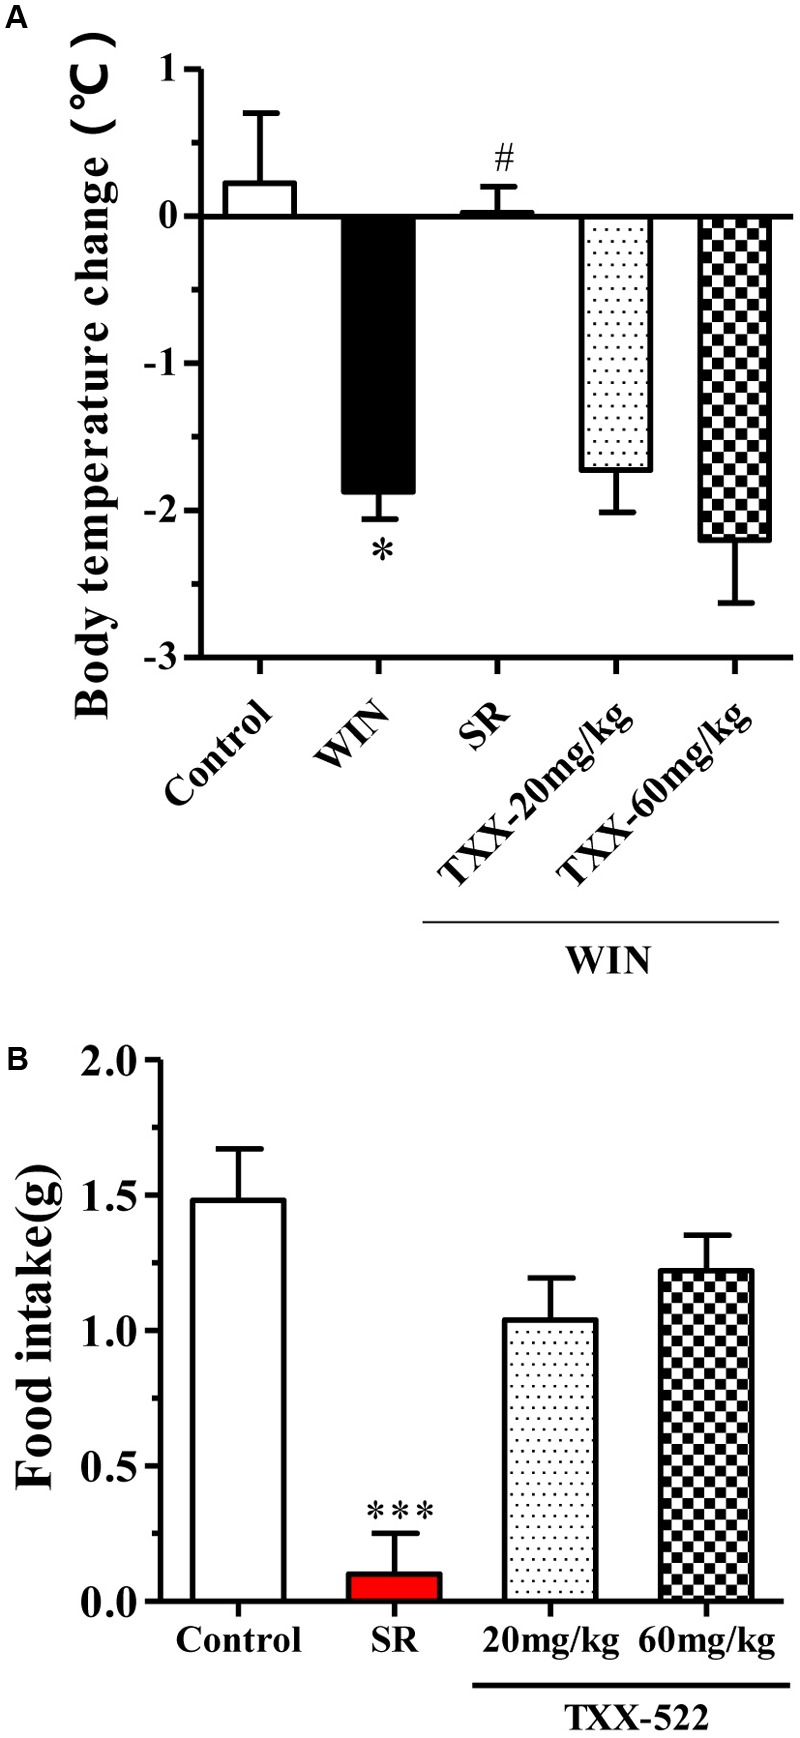
Effects of TXX-522 and SR141716A on WIN 55,212-2-induced hypothermia and acute food intake in C57BL/6 mice. (A) Body temperature change 30 min after intraperitoneal injection of WIN 55,212-2 (WIN, 3 mg/kg), following oral administration of SR141716A (SR, 10 mg/kg) or TXX-522 (TXX, 20 or 60 mg/kg). Data are means ± SEM, n = 5; ∗P < 0.05 vs. vehicle control group, #P < 0.05 vs. the WIN 55,212-2-treated control mice. (B) Acute food intake for first 3 h of dark phase, which commenced 30 min after oral administration of SR141716A (10 mg/kg) or TXX-522 (20 or 60 mg/kg) to 24-h fasted mice via gavage. Data indicate the mean ± SEM, n = 5; ∗∗∗P < 0.001 vs. vehicle control group.